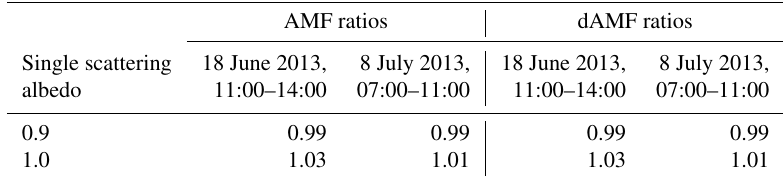
Table A7. Average ratios of O 4 (d)AMFs simulated for different aerosol single-scattering albedos (SSAs) vs. the results for the standard settings (single-scattering albedo of 0.95) for the middle period on each selected